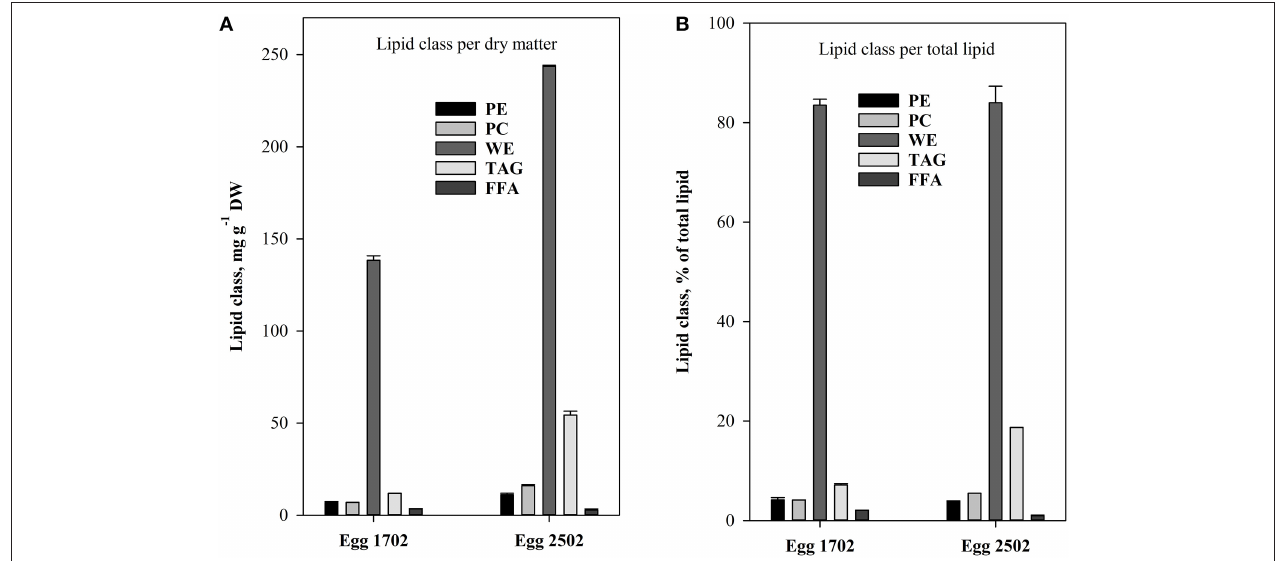
FIGURE 4 | Content of the different lipid classes: phosphatidylethanolamine (PE), phosphatidylcholine (PC), wax ester (WE), triacylglycerol (TAG), and free fatty acids (FFA) in C. finmarchicus eggs. (A) Quantitative content (mg g − 1 DW). (B) Relative content (% of total lipids). Error bars equals standard error ( n = 2).